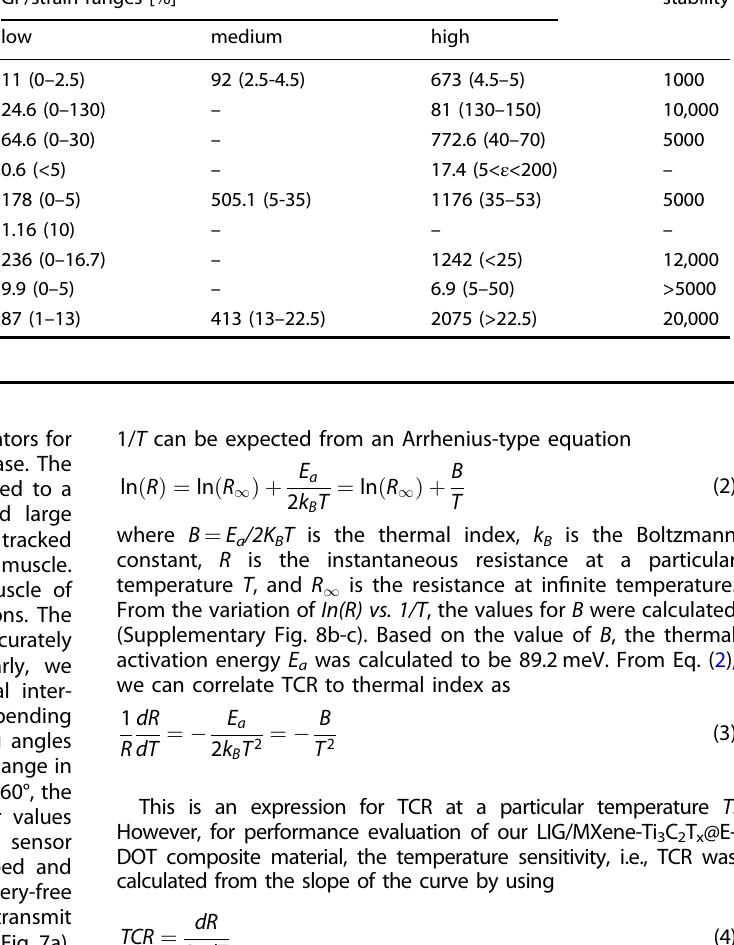
Table 1. Comparison of the performance of the recent piezoresistive strain sensors and their sensing materials.